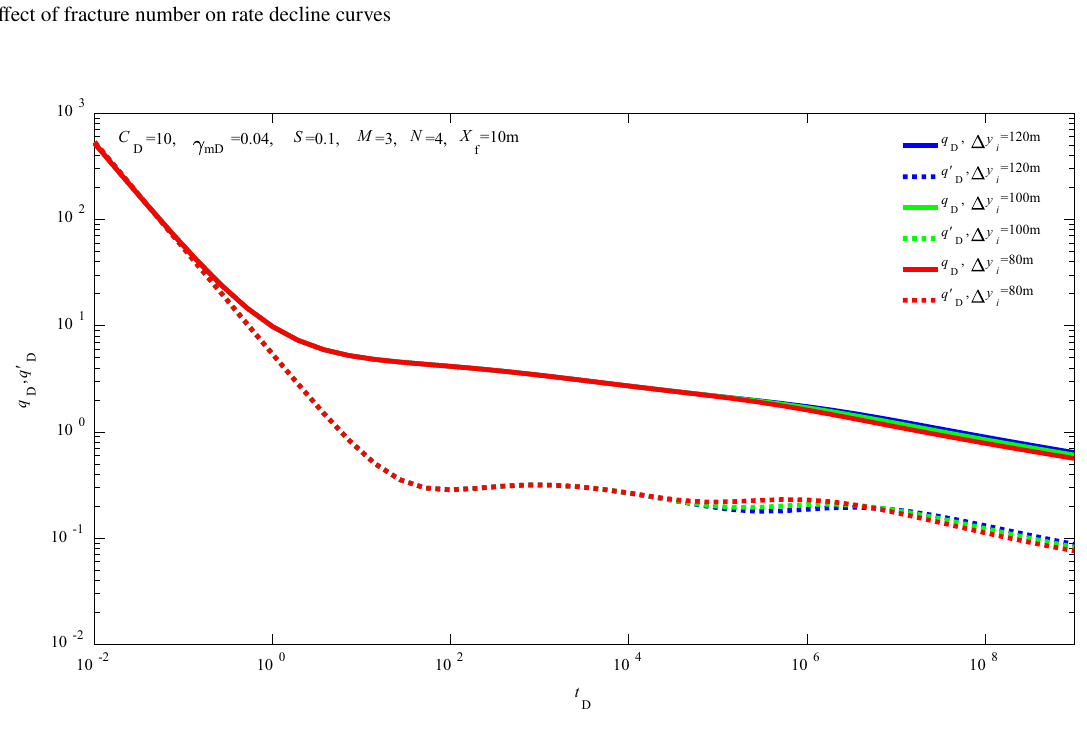
Fig. 10 Effect of fracture spacing on rate decline